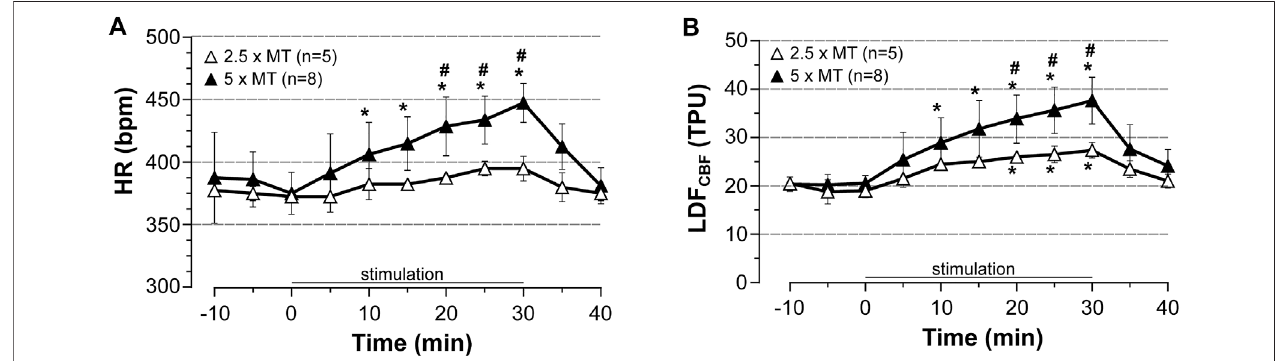
FIGURE5| In fl uenceofstimulationintensityofinducedcontraction-associatedcardiovasculareffects.HRandLDF CBF inthecorticalarearepresentingthehindlimb were recorded before, during (0 – 30 min) and after electrically induced contraction of hindlimbs at 2.5 or 5x motor threshold. Values are expressed as means ± SD, n = numberofrats.*signi fi cantlydifferentfrompre-stimulationvaluesat p < 0.01, # signi fi cantdifferencebetweenlowandhighintensityaftertwo-way(timexgroup)ANOVA and Bonferroni correction.